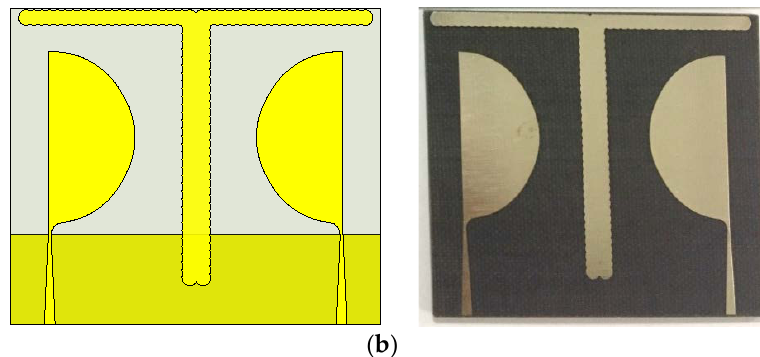
Figure 5. The schematic diagram ( a ) ( left side ) fabricated ( right side ) without t-shape corrugated strip and ( b ) ( left side ) fabricated ( right side ) with t-shape corrugated strip of the MIMO antenna.